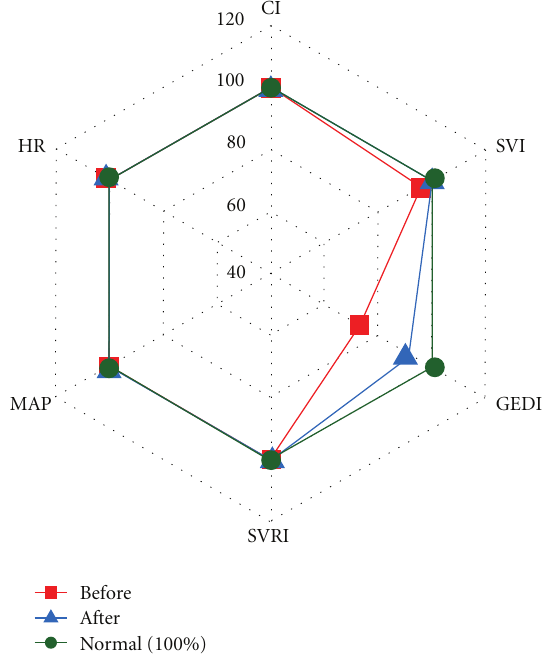
Figure 5: Variant STBI-b of hemodynamic reaction before (the first measment) and after correction in the patients of group STBI on the first day. Note. Hemodynamic parameters are presented with percents from the normal value.